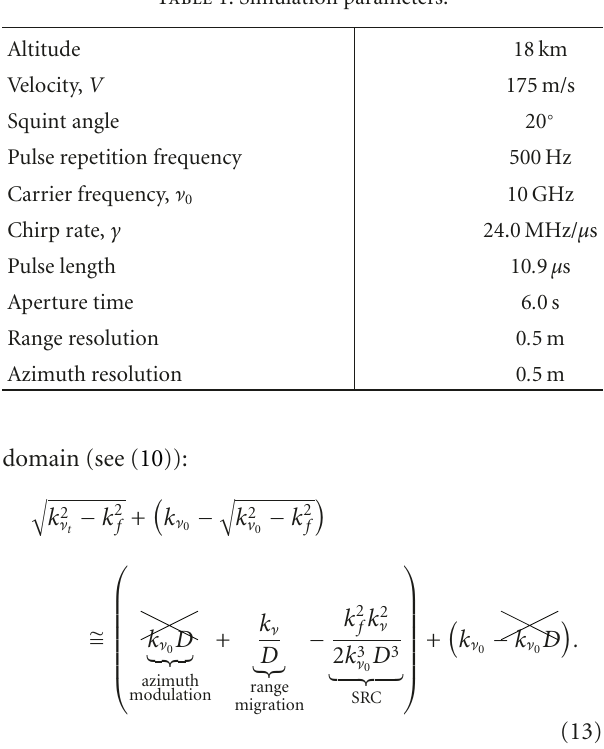
Table 1: Simulation